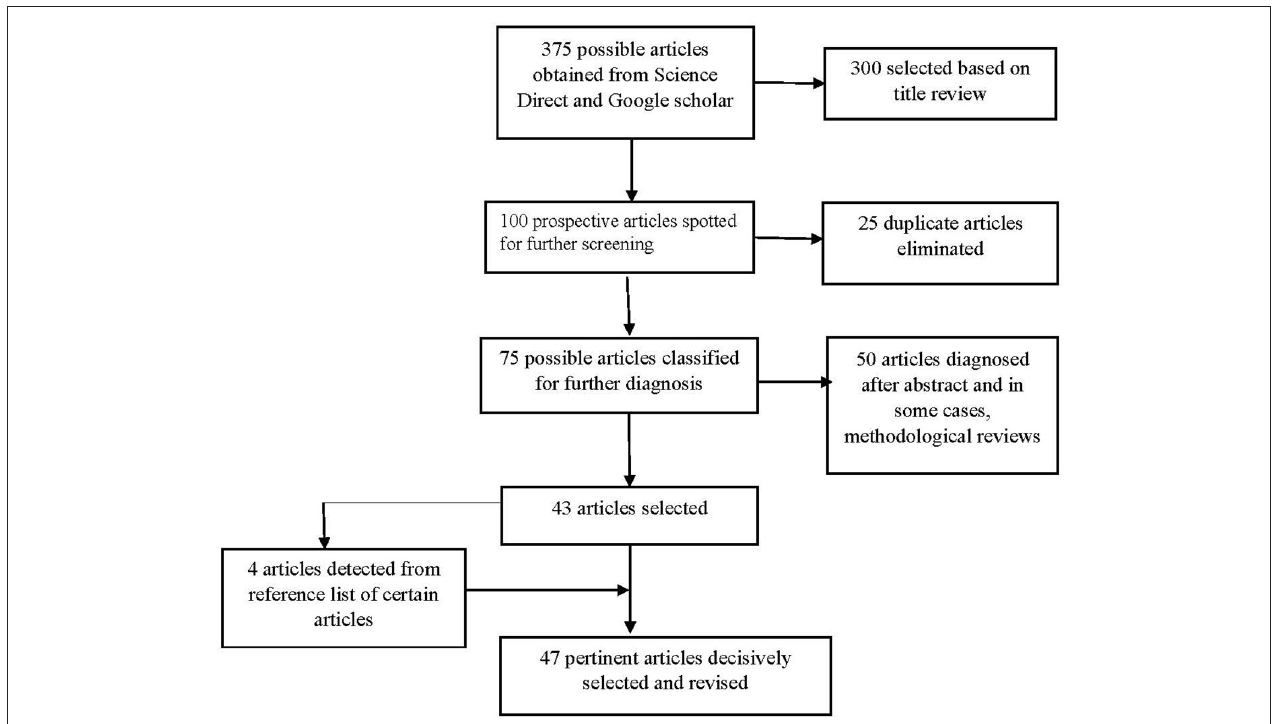
FIGURE 1 | Flow diagram showing the different phases of selecting relevant